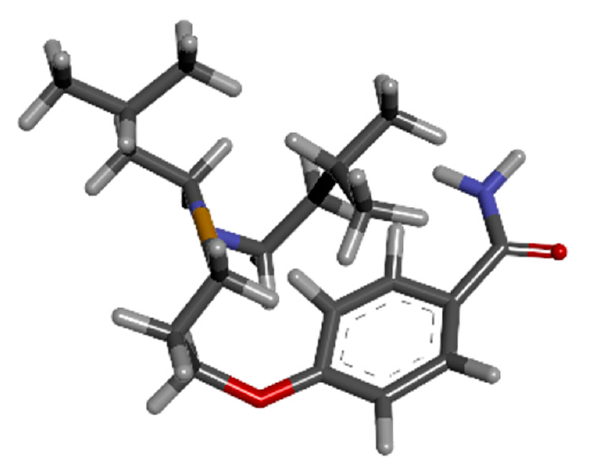
Figure 7. The 3D structure of molecule 2 of Gamma-Tocotrienol AI drug design from WADDAICA.